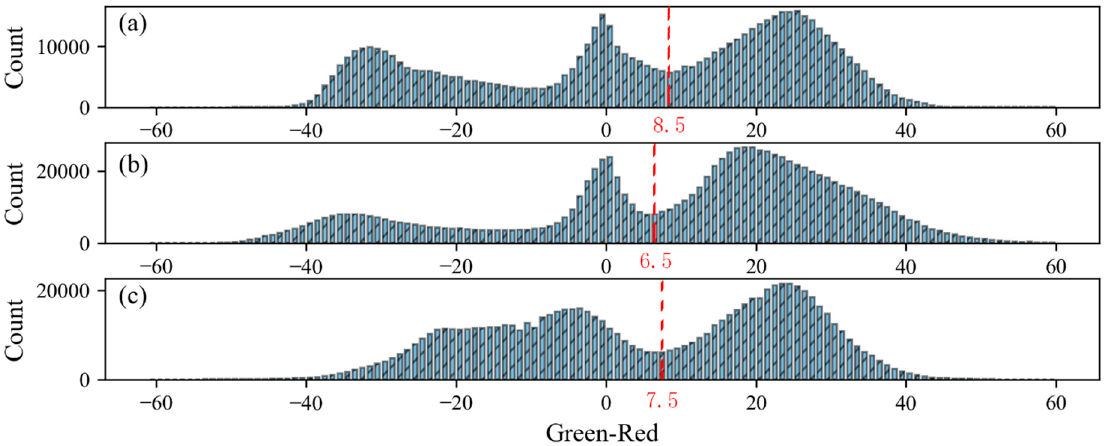
Figure 4. G-R mean value of all sugar beet point clouds at ( a ) T1, ( b ) T2 and ( c ) T3 period. The red dotted line is the (G-R) value separating plants from soils and shadows.